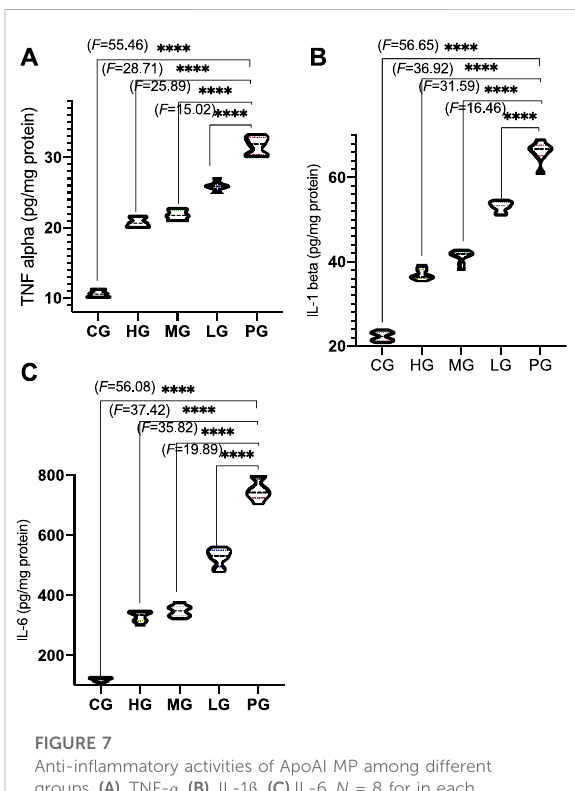
FIGURE 7 Anti-in fl ammatory activities of ApoAI MP among different groups . (A) , TNF- α . (B) , IL-1 β . (C) ,IL-6 . N = 8 for in each group. **** p < 0.0001 vs. the PG group.